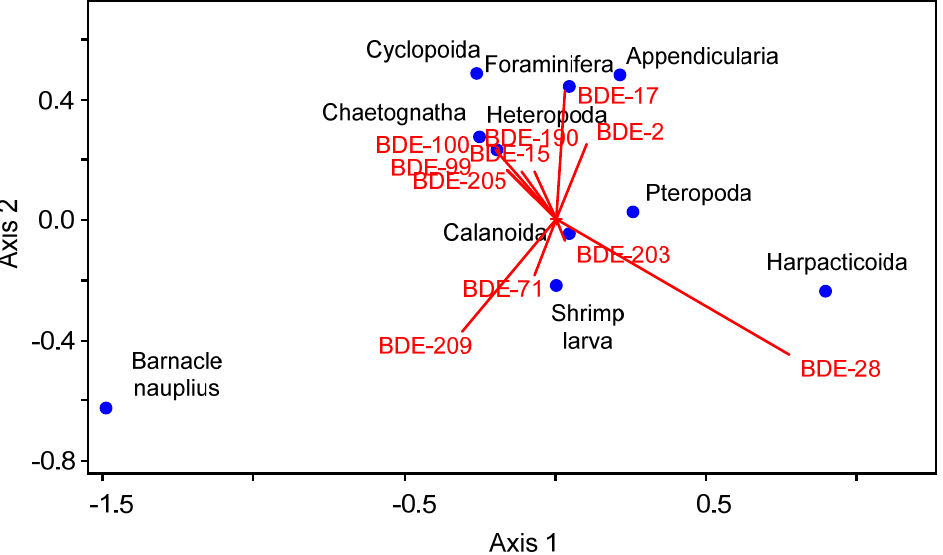
Figure 4. Ordination diagram of the canonical correspondence analysis (CCA) based on the 10 most dominant taxa and 11 PBDE congener concentrations of zooplankton.